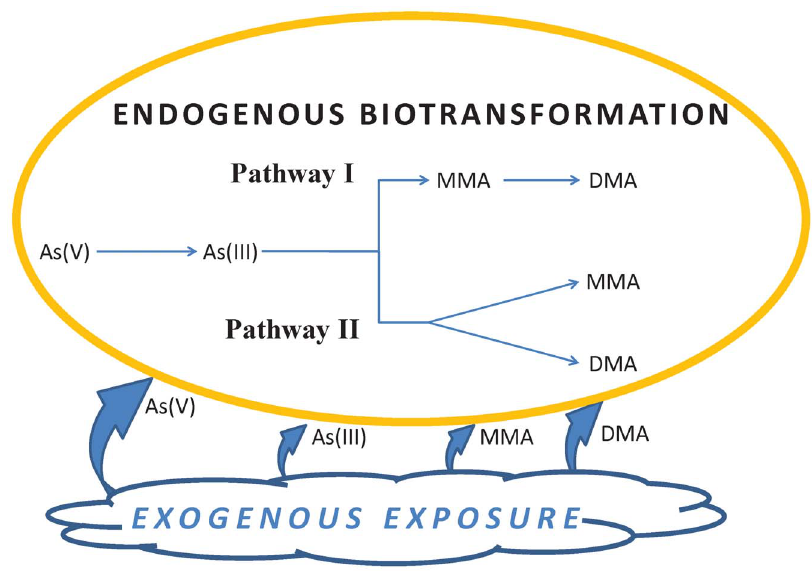
Figure 1. Biotransformation pathways for arsenic species As(III), As(V), DMA, and MMA.